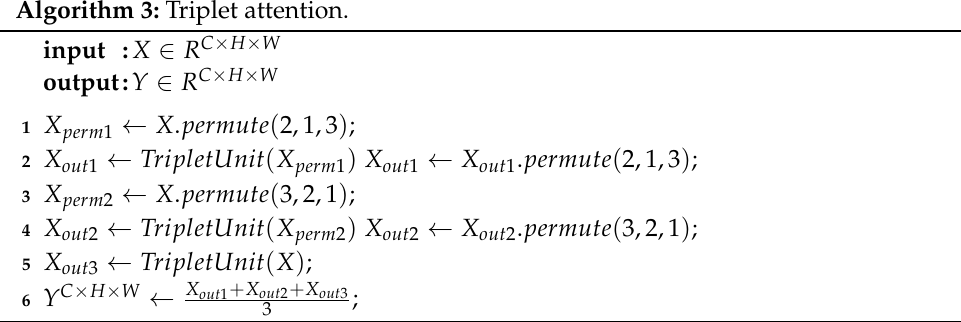
Algorithm 3: Triplet